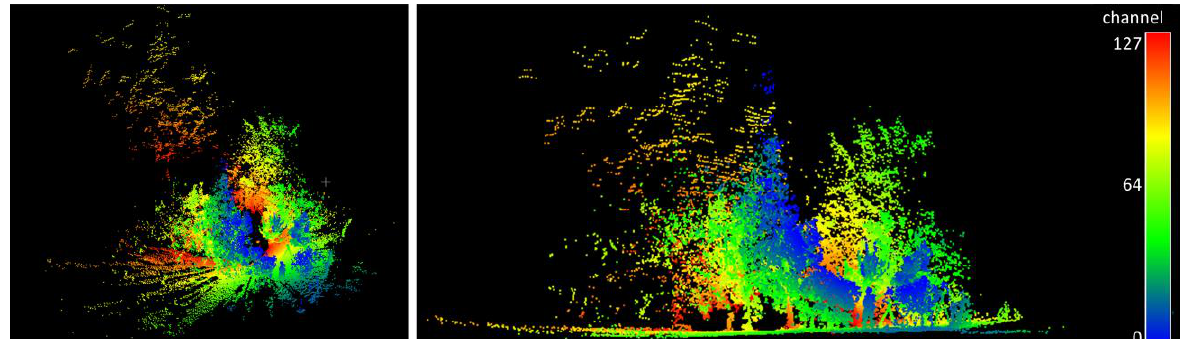
Figure 4. The point cloud obtained in a single turn (360°) with OS0-128 laser